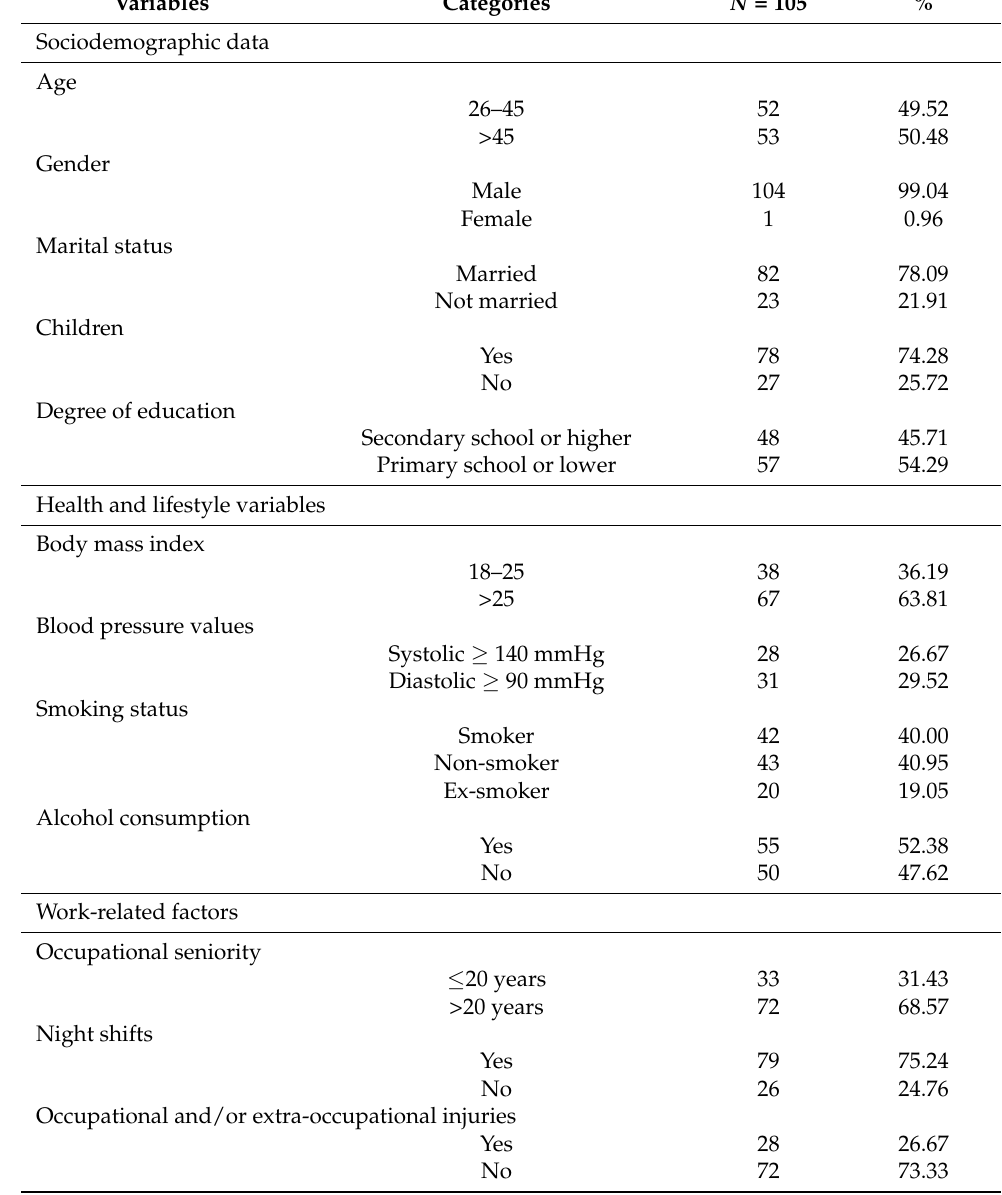
Table 1. Sociodemographic characteristics and lifestyle of study